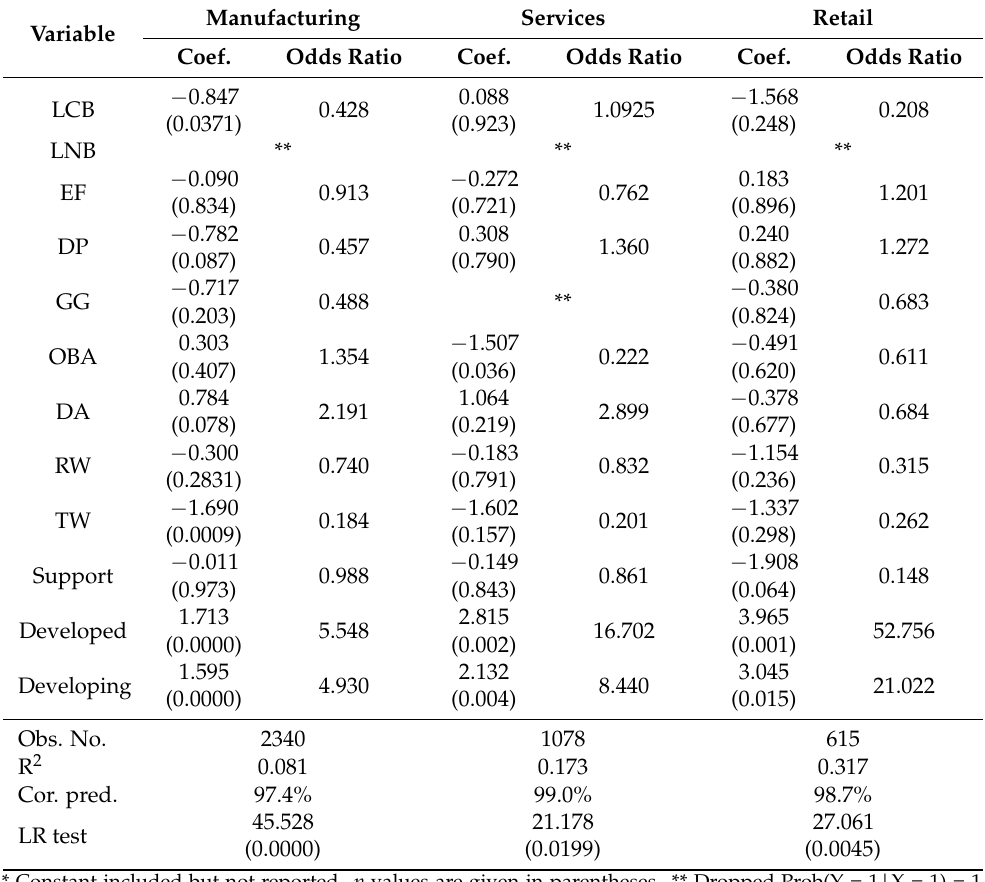
Table 6. Logit binary model’s estimation results *—export decrease. Manufacturing Services Variable